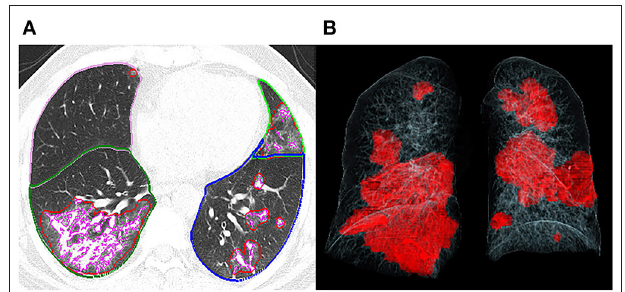
FIGURE 1 | Representative postprocessing result of chest CT scan performed with Siemens CT Pneumonia Analysis. A 56-year-old male with COVID-19 (Opacity score = 5, volume of opacity = 671.6ml, percentage of opacity = 15.1%). (A) Axis plane of chest CT shows bilateral ground glass opacities. (B) 3D-visualization of CT volume rendering technique shows the diffuse extent of opacities.